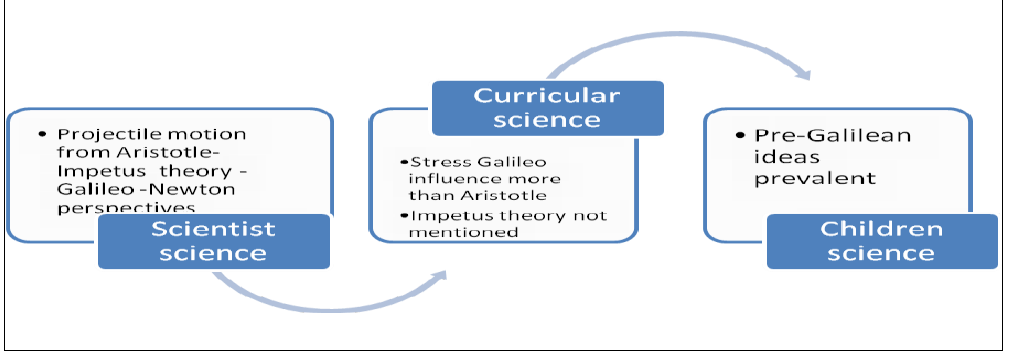
Figure 1: Force and Motion Conceptual Framework; Source: Sikhosana, L., & Mudau,